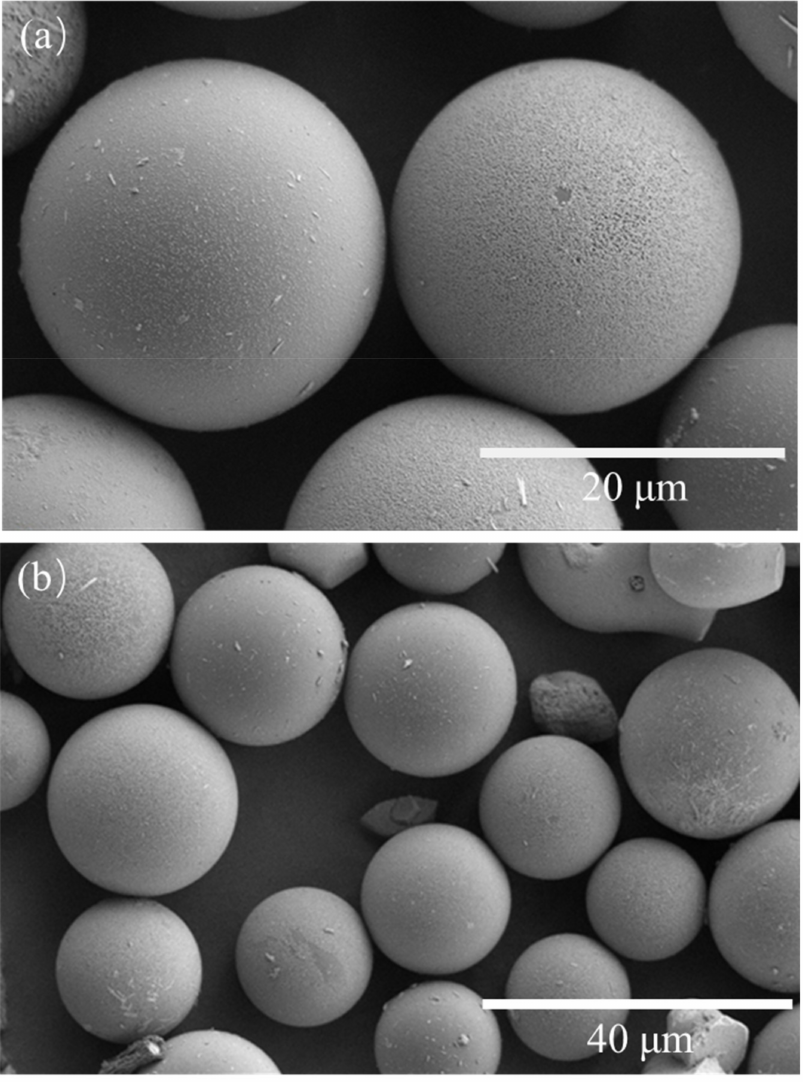
Figure 1. SEM images of TSF microcapsules at ( a ) 8000 times magnification and ( b ) 4000 times